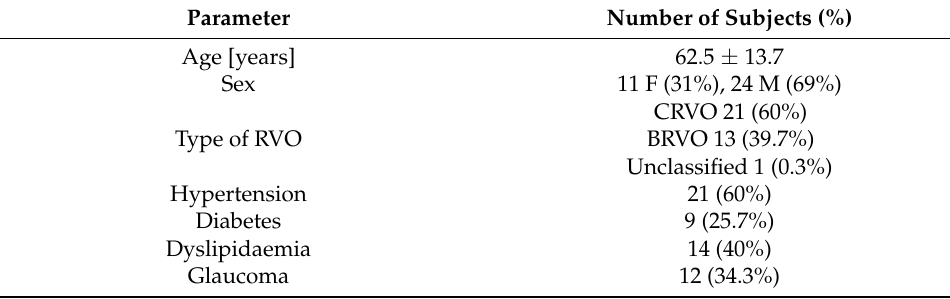
Table 1. Basic characteristics of RVO patients ( n =